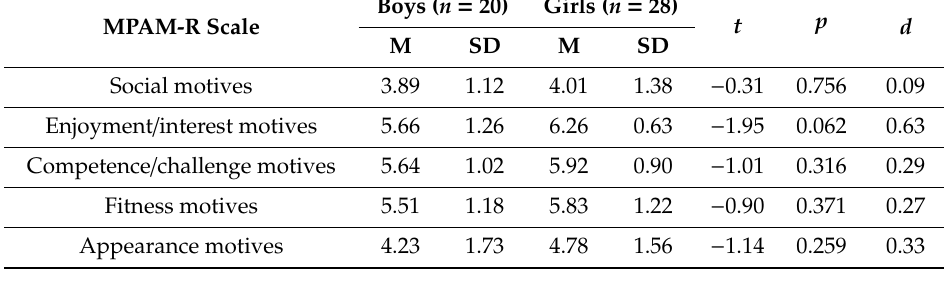
Table 3. Differences in motivation depending on gender. SD: standard deviation.